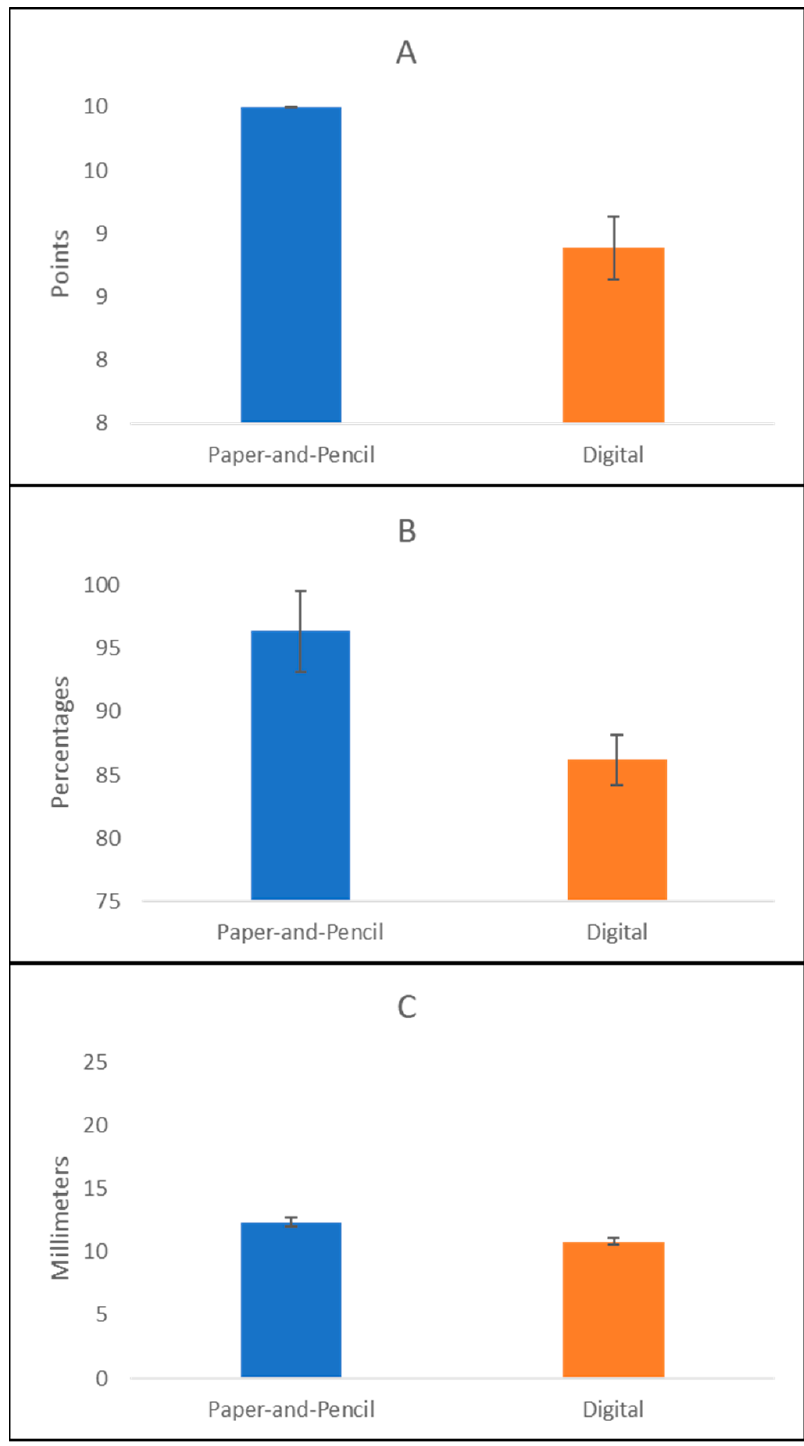
Figure 3. Mean performance scores in the paper-and-pencil vs. digital tests in healthy participants. Error bars represent ± 1 SD. Panel ( A ) Drawing tests; Panel ( B ) Cancellation tests; Panel ( C ) Digital Line Bisection test.